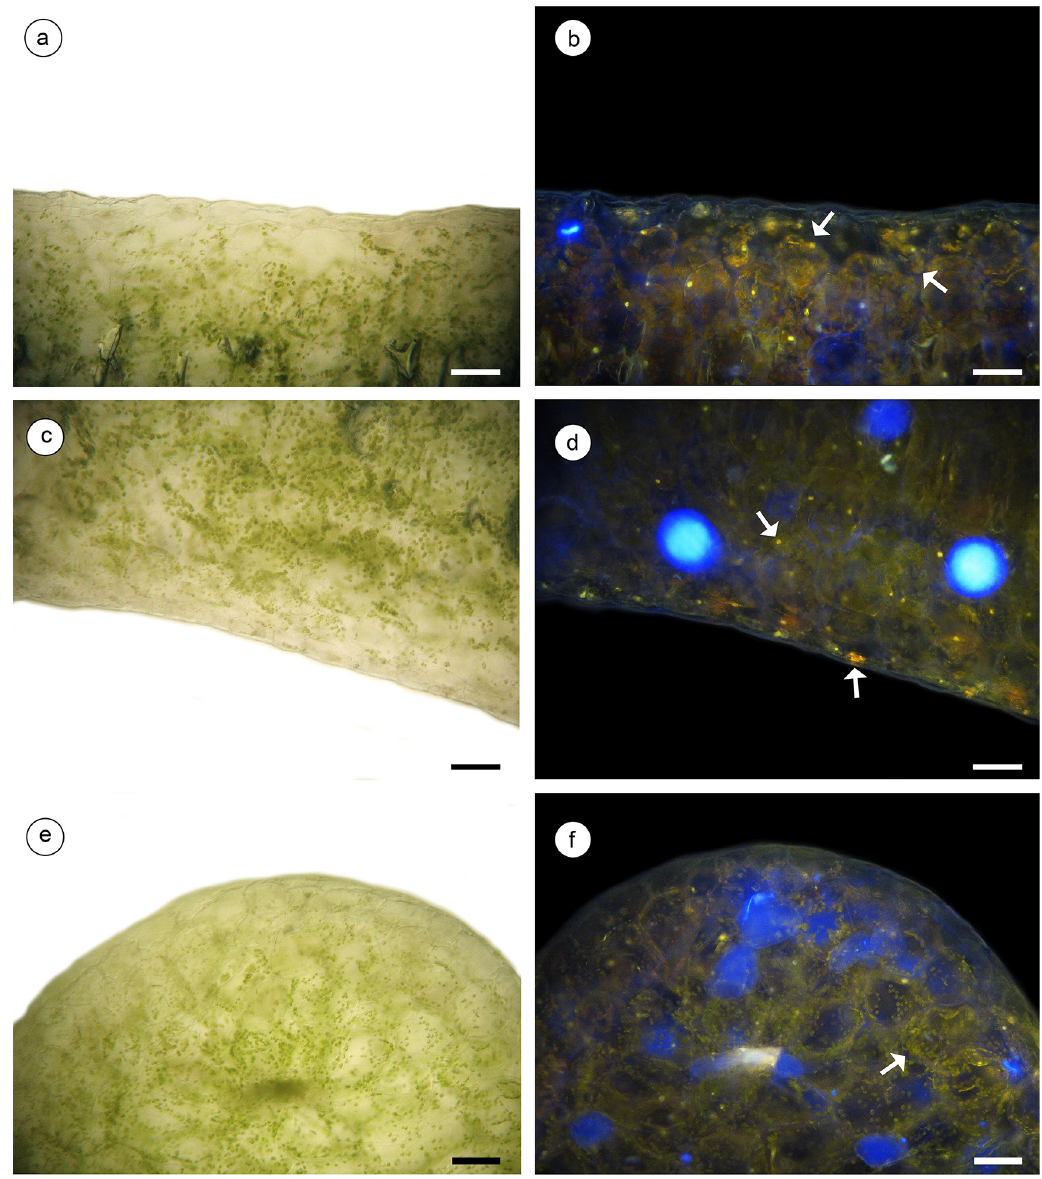
Fig. 6: Cross sections of Kalanchoe fedtschenkoi leaf blade at the middle third (NP treatment): adaxial side (a, b); abaxial side (c, d); leaf margin (e, f); visible light (a, c, e); UV light (b, d, f); yellow flavonoids (arrows). Bars 100